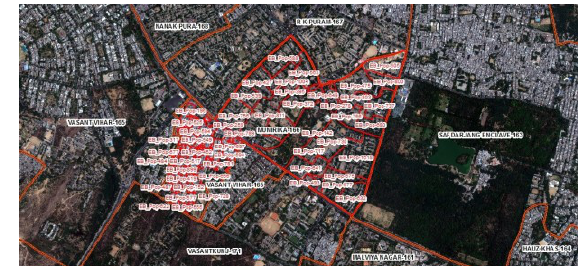
Figure 7 EB & EBG Boundaries with Population